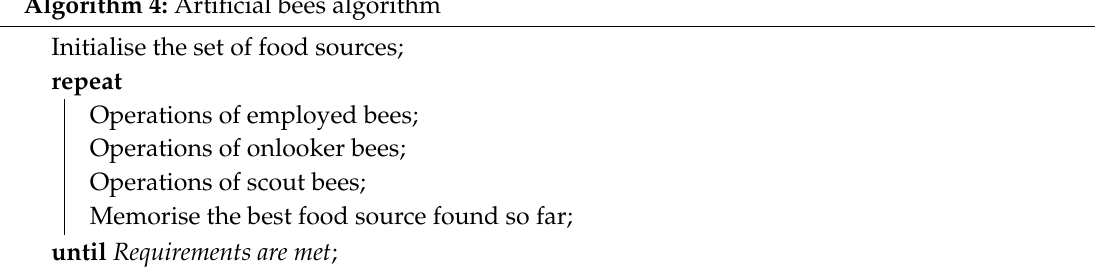
Algorithm 4: Artificial bees algorithm